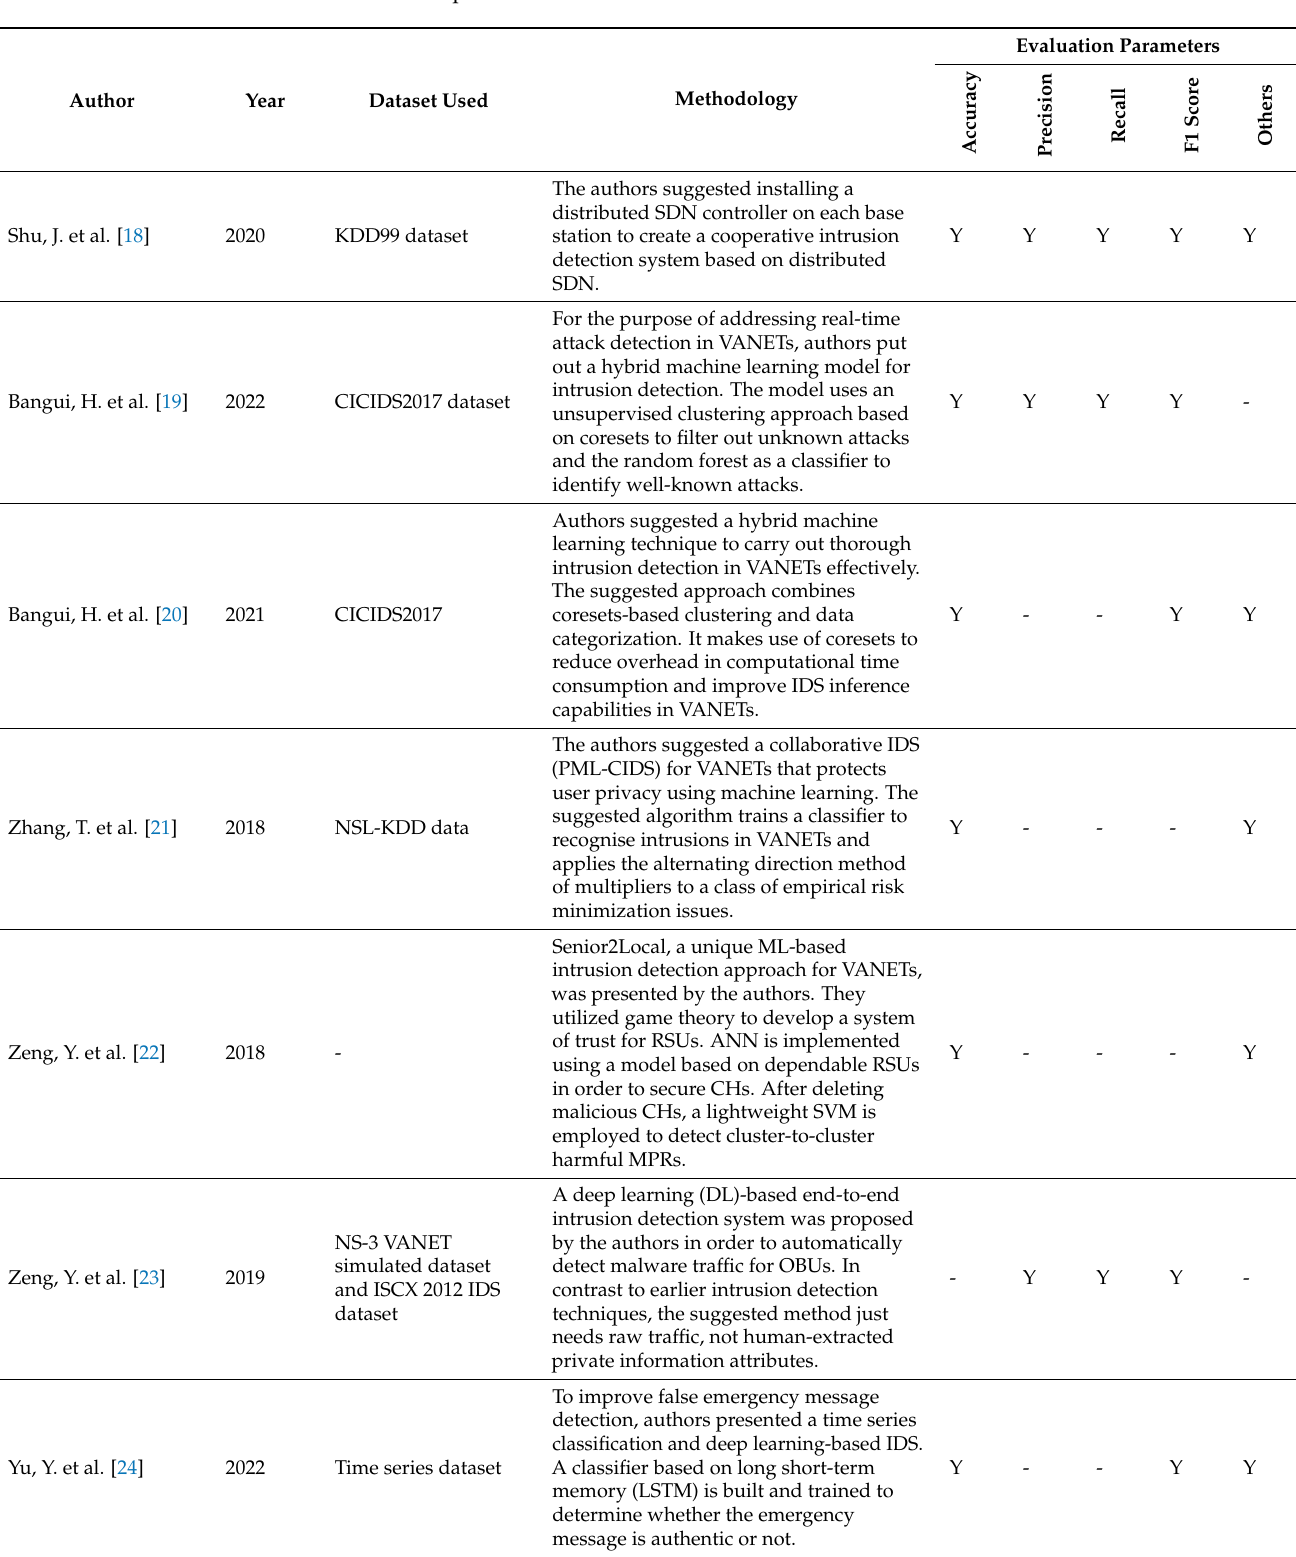
Table 1. Comparison of recent